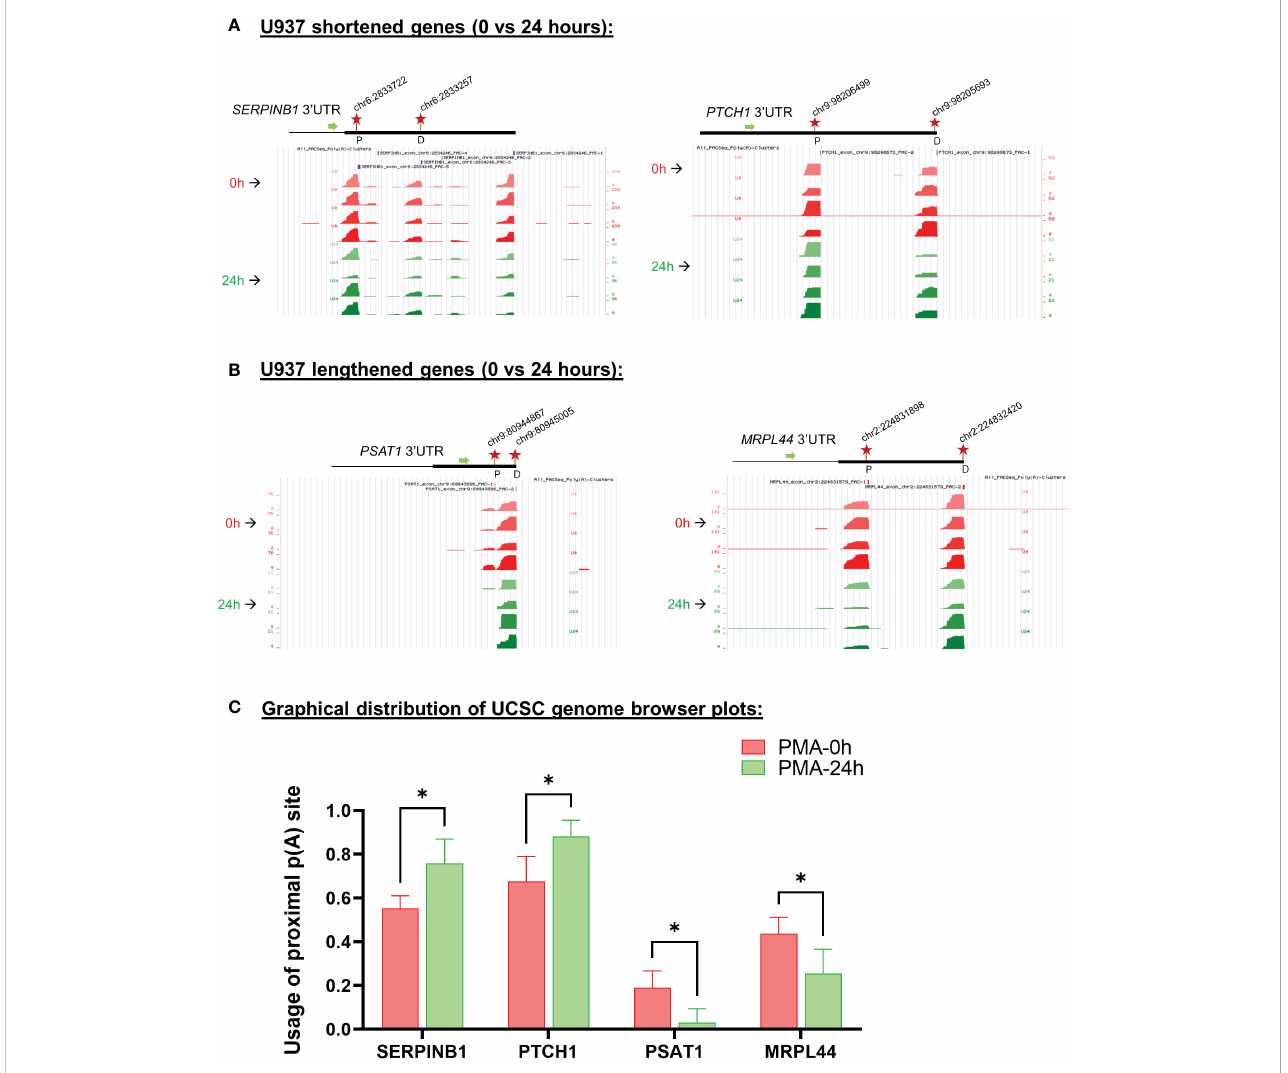
FIGURE 4 Changes in poly(A) site use in U937 cells after 24 hours of PMA treatment. UCSC genome browser plots of RNA sequencing tracks highlighting the 3 ′ -UTR pro fi le differences for shortened genes (A) or lengthened genes (B) after 24 hours of PMA treatment with respect to control (0h). The colors of the tracks represent 0h (red) and 24h (green). Proximal (P) and distal (D) poly(A) sites are indicated with red stars. The green arrow de fi nes the direction of the coding strand, and tag counts are indicated on the y axis. Additionally, positions and chromosome co-ordinates of the annotated PACs are indicated at the top of each plot. (C) Quantitative bar graphs re fl ecting the differences in APA for shortened and lengthened targets. The mean relative usage of proximal poly(A) site with respect to the total read counts at the proximal and distal poly(A) sites as visualized in the UCSC genome browser is plotted for each target. Unpaired t-test was performed to determine the signi fi cance between the treatment groups and P value <0.05 was considered signi fi cant.where * = P ≤